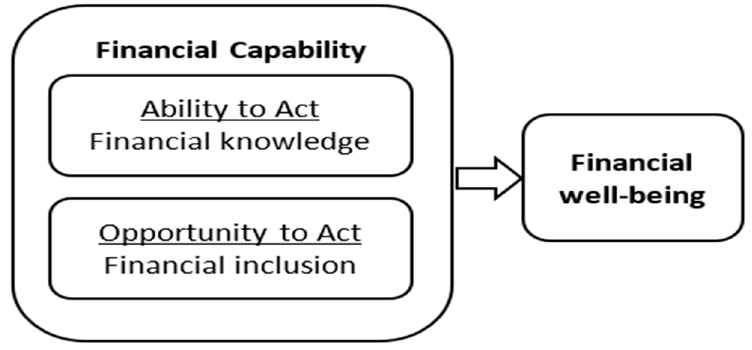
Figure 1. A conceptual framework of financial capability.